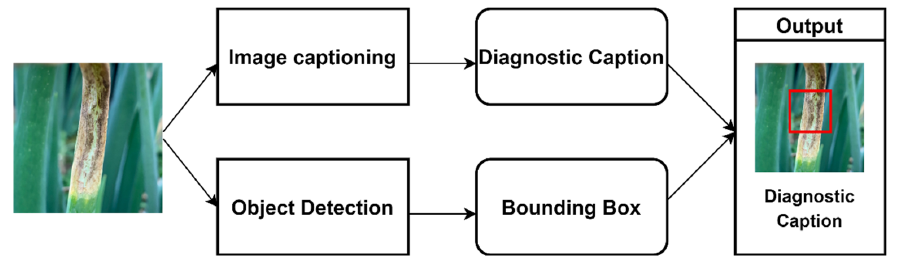
Figure 10. Structural Diagram of Crop Disease Diagnosis Solution.